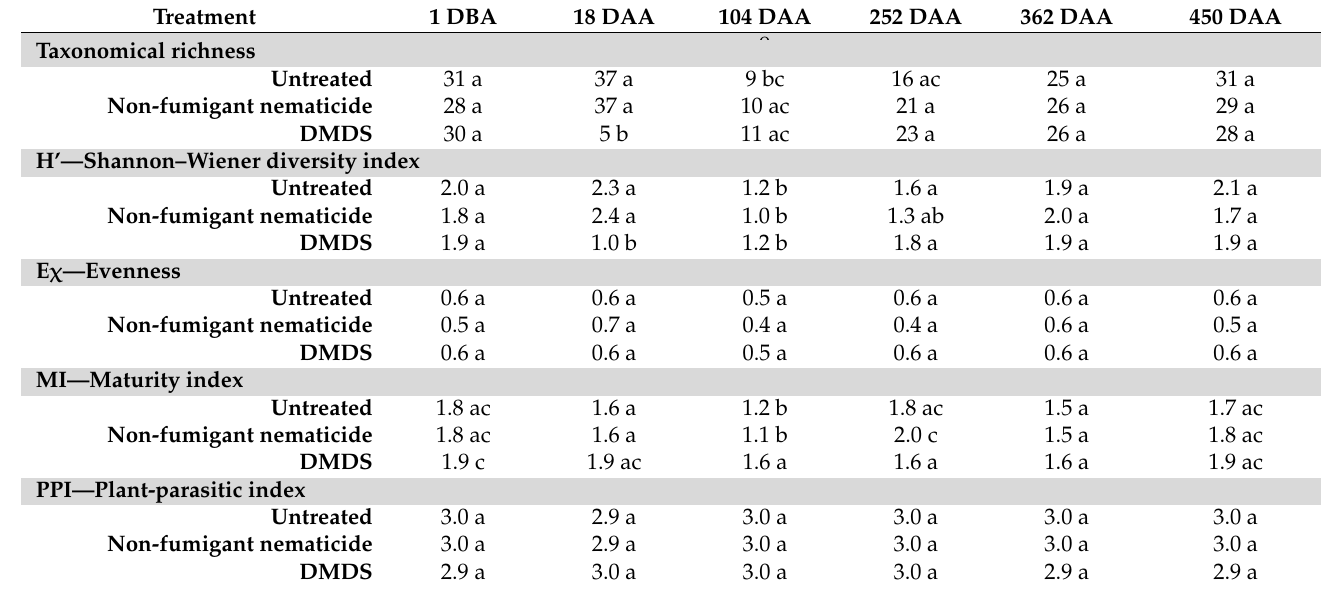
Table 6. Diversity and functional indices of nematode community in different trial treatments during the study period.